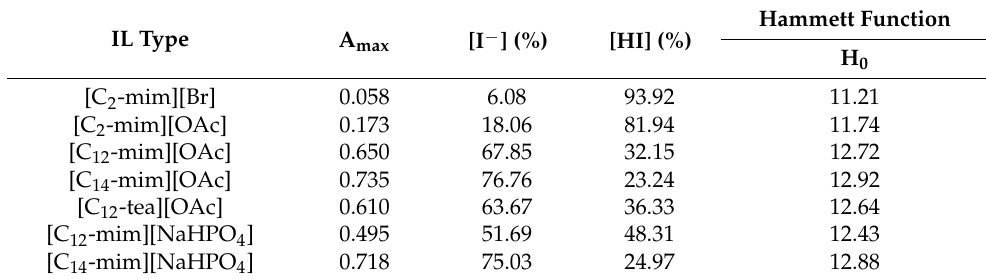
Table 1. Values of Hammett function (H 0 ) of ionic